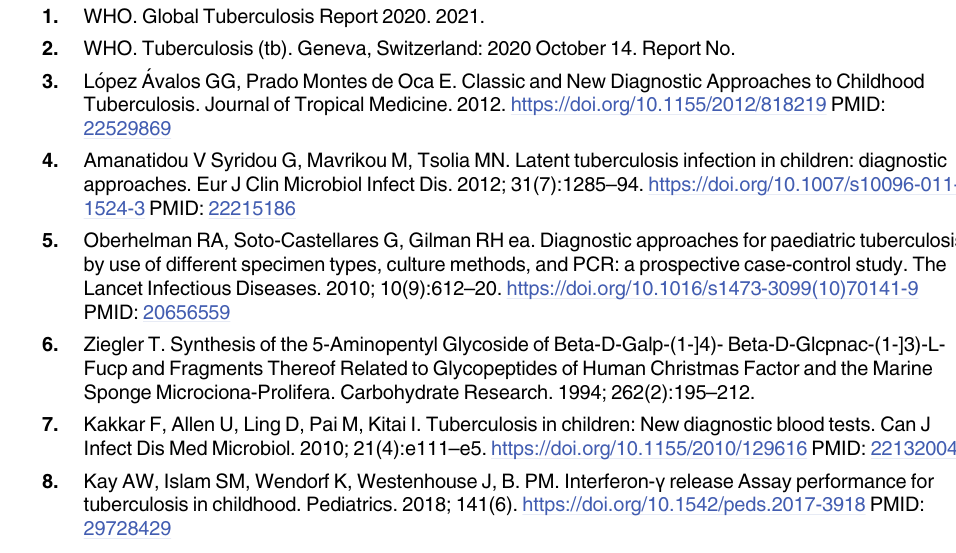
values and clinical status for 25 adult urine samples.